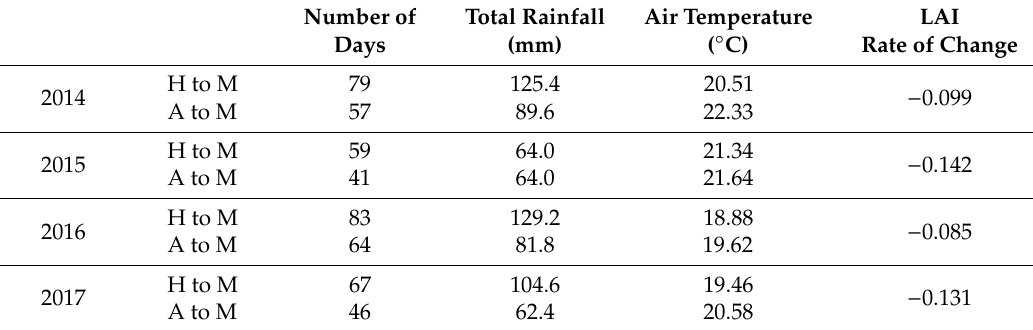
Table 4. Climate conditions, phenological length for heading to maturity (H to M) and anthesis to maturity (A to M), leaf area index (LAI) function derivative rate of change for the four crop seasons from anthesis to maturity.